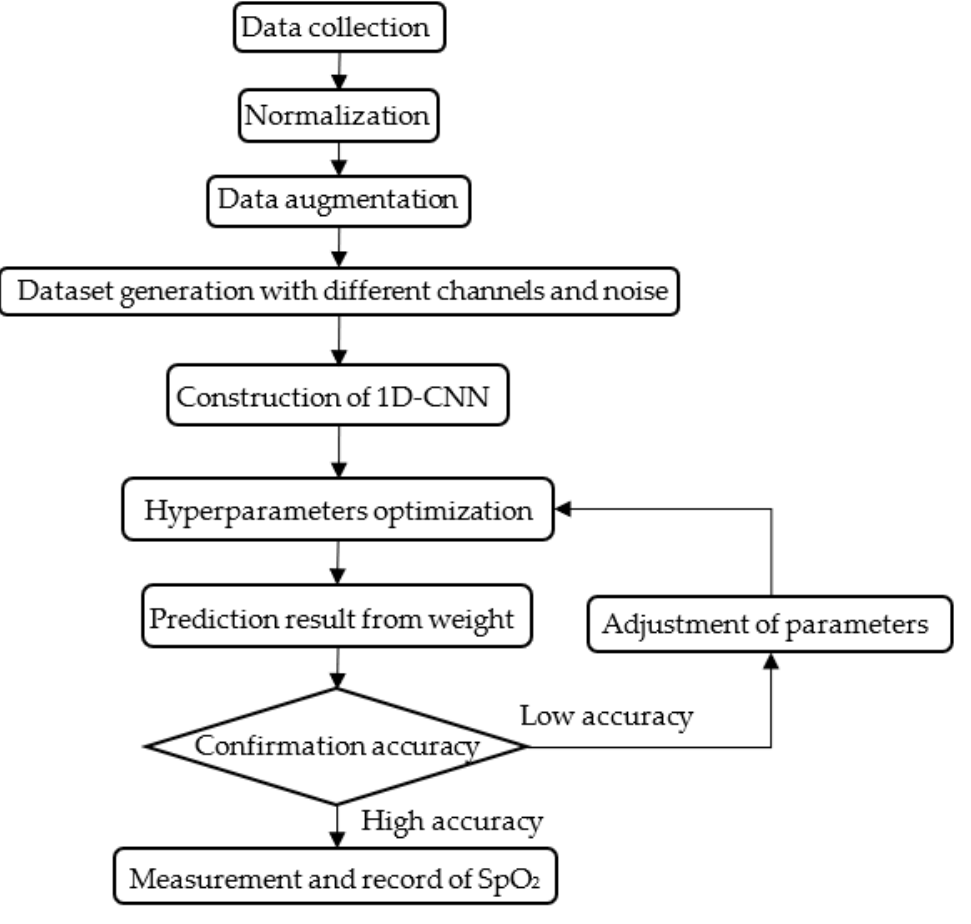
Figure 5. Experiment flow